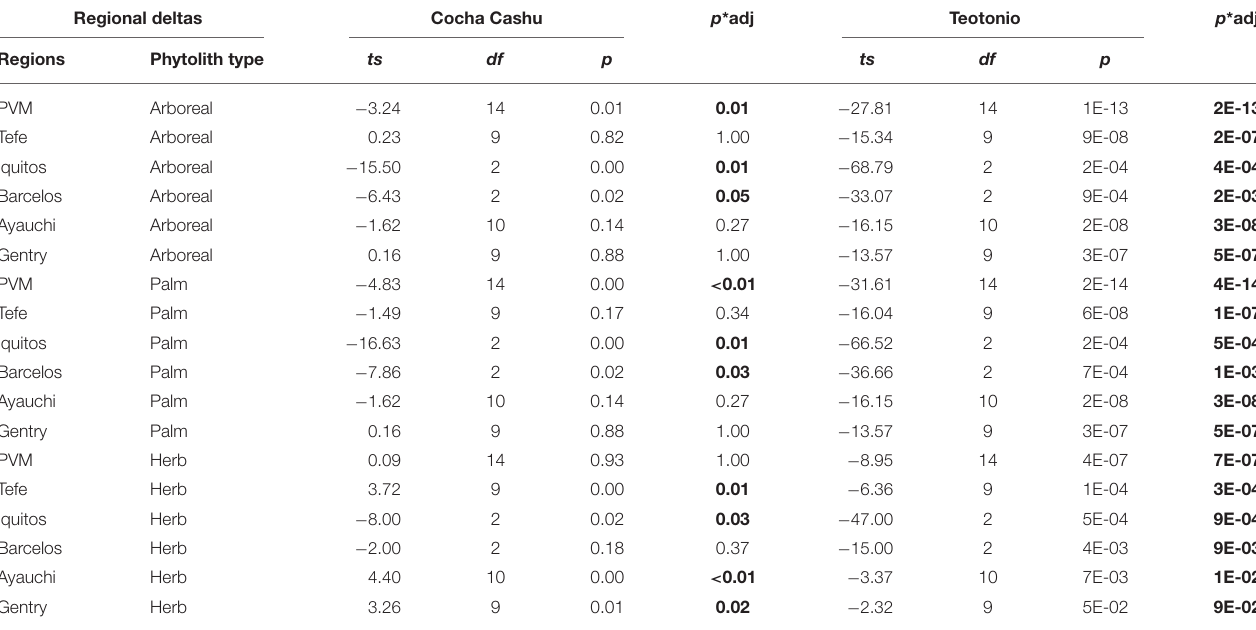
TABLE 3 | One-sample t -test results from regional comparisons of delta values (delta = maximum–minimum) of arboreal, herb and palm phytoliths with values obtained at Cocha Cashu and Teotônio. Regional deltas